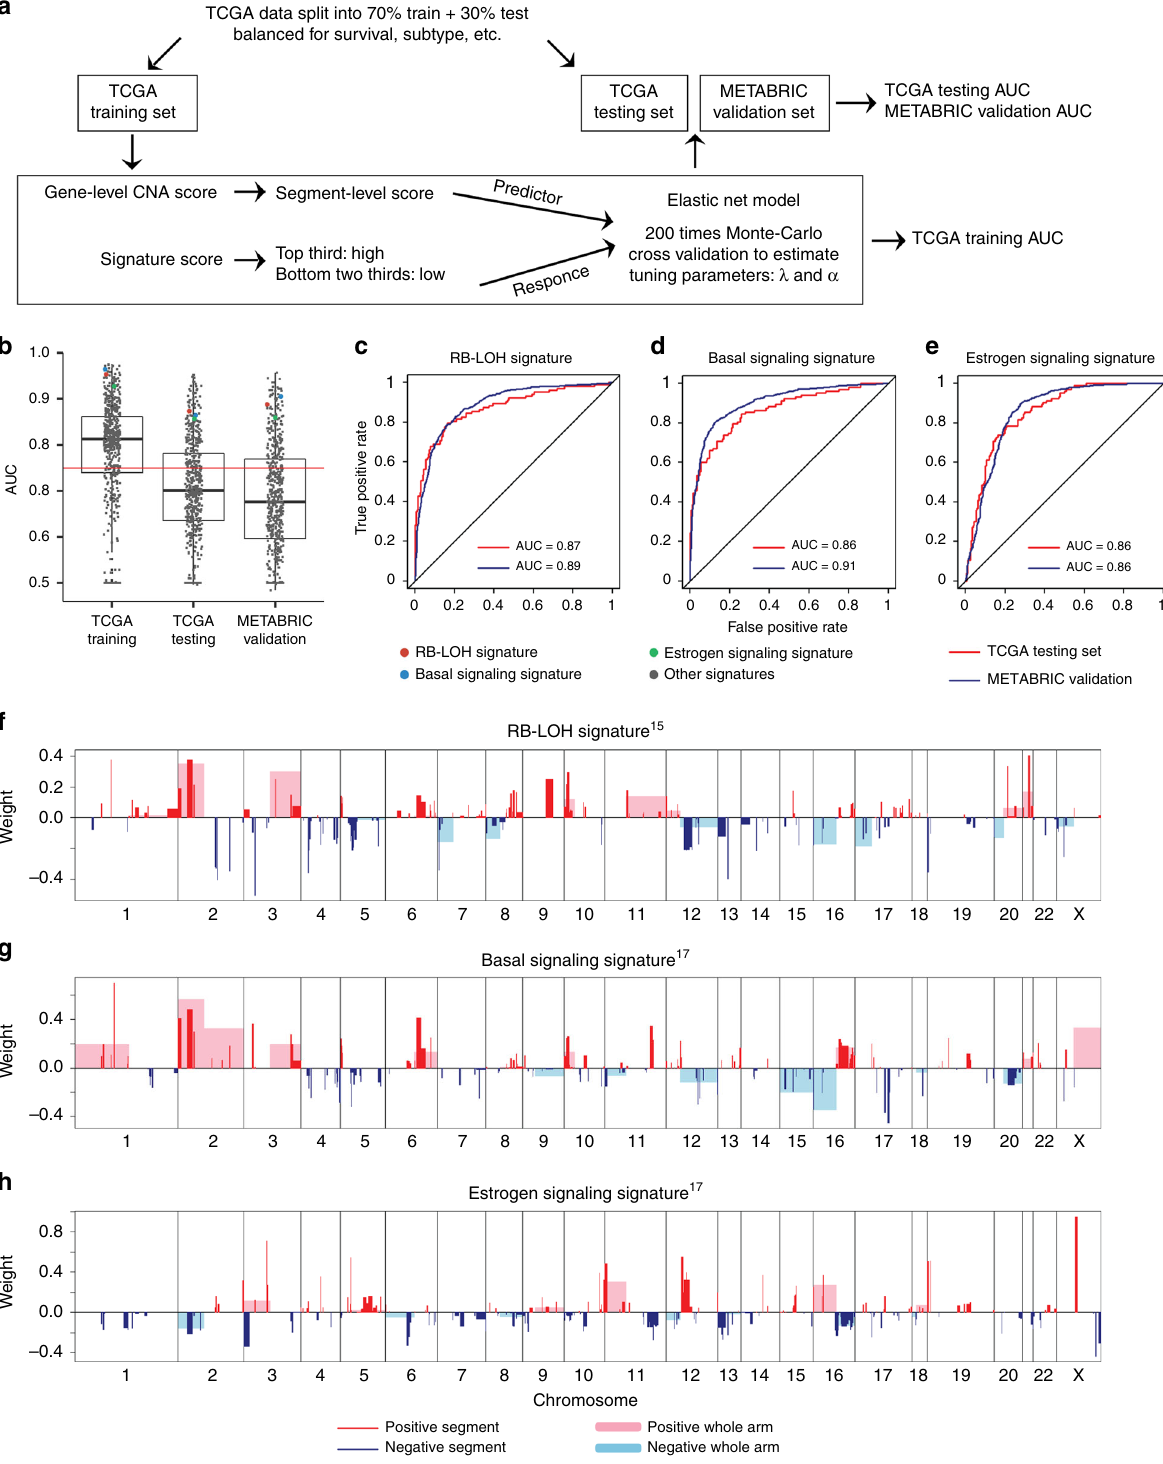
Fig. 2 CNA-based Elastic Net prediction models for gene signatures in breast cancer. a Schematic overview of the strategy used to build Elastic Net models for predicting gene expression signature levels. b Area under curve (AUC) values for 543 signatures displayed using box and whisker plots indicating the median score (horizontal line), the interquartile range (IQR, box boundaries) and 1.5 times the IQR (whiskers); the red horizontal line indicates AUC = 0.75, which we consider to be “ highly predicable ” . Three signatures are highlighted with colored dots, and their feature landscapes also shown in f – h . c – e Receiving operating characteristics (ROC) curves and corresponding AUC values of TCGA test set and METABRIC validation set for predicting RB-LOH ( c ), basal signaling ( d ), and estrogen signaling ( e ) signatures. f – h Elastic net selected CNA segments and/or whole chromosomal arms and their coef fi cients for prediction models for RB-LOH ( f ), basal signaling ( g ) and estrogen signaling ( h )